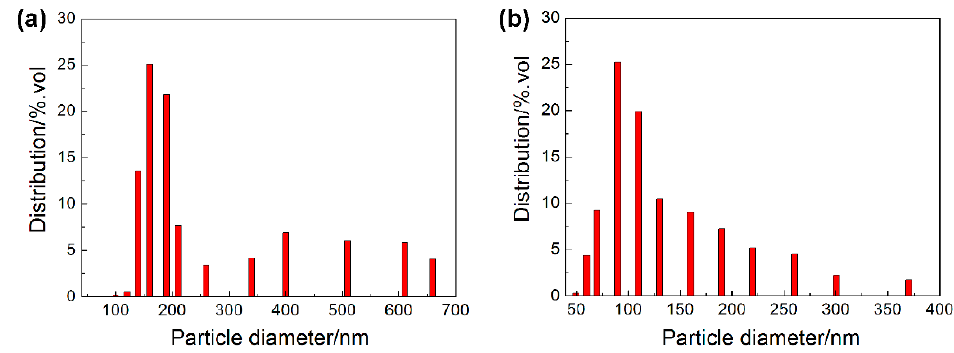
Figure 2. Size distribution of powders: ( a ) 200 nm, ( b ) 100 nm.